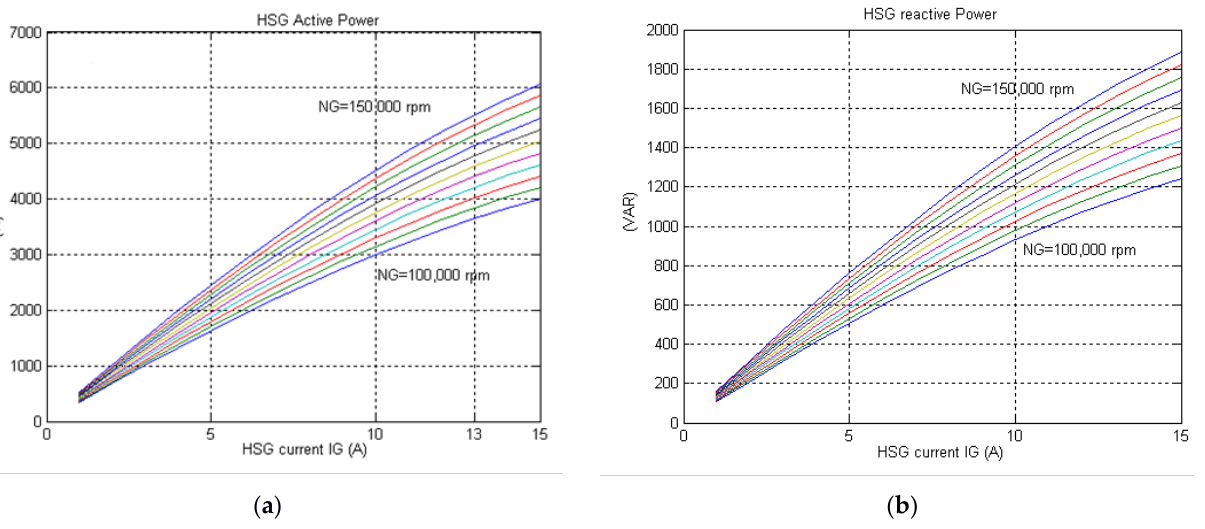
Figure 10. ( a ) Calculated HSG Active Power as a function of the HSG current IG varying the MGT speed from 100 to 150 krpm; ( b ) Calculated HSG reactive Power as a function of the HSG current IG varying the MGT speed from 100 to 150 krpm.